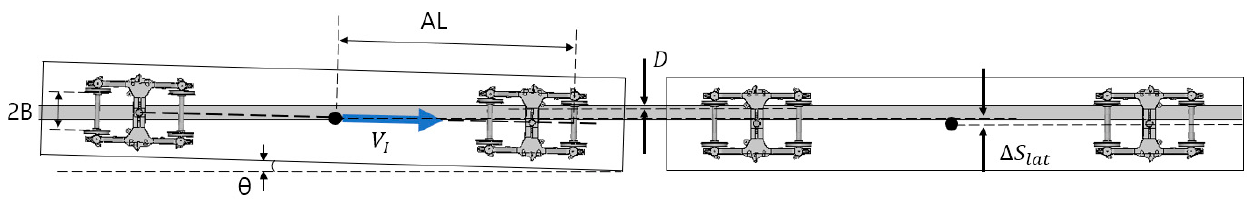
Figure 6. Olson model applied for the DCP Type 1.